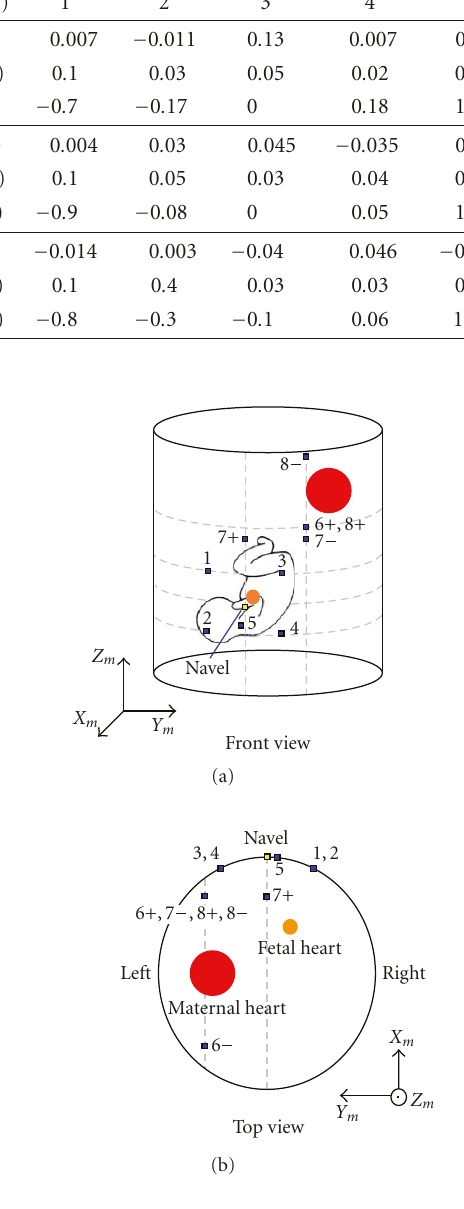
Figure 8: Model of the maternal torso, with the locations of the maternal and fetal hearts and the simulated electrode